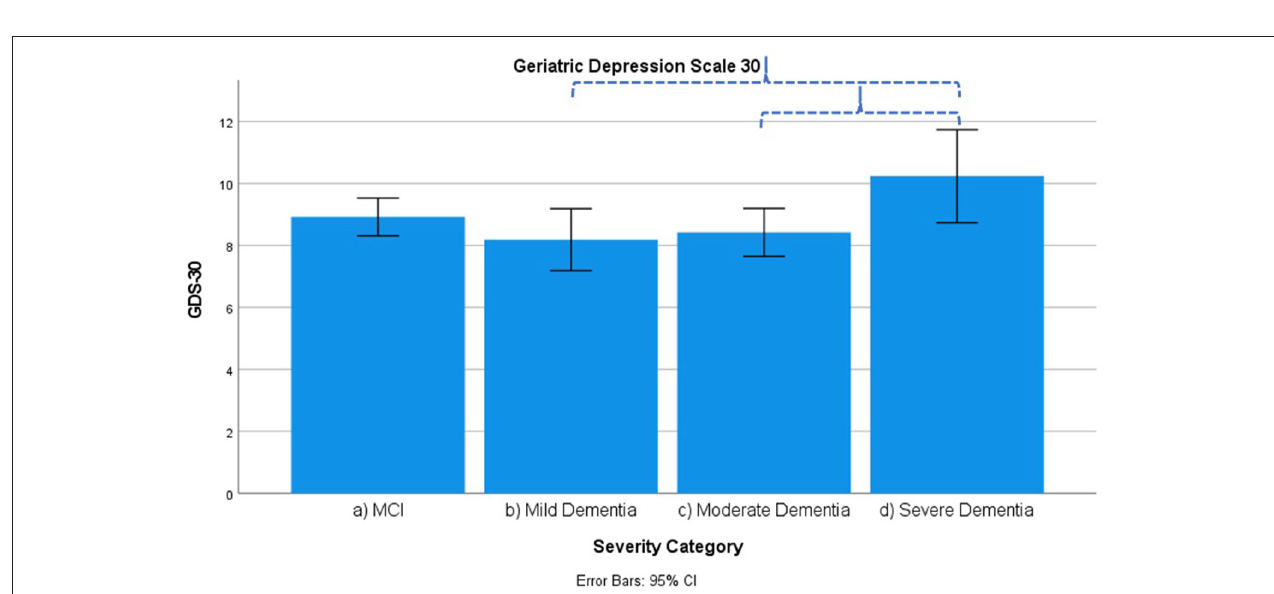
FIGURE 6 | Mean score on the Cornell Scale for Depression in Dementia (CSDD) according to severity of cognitive impairment. Error bars are 95% confidence interval. Curly brackets indicate p < 0.001.